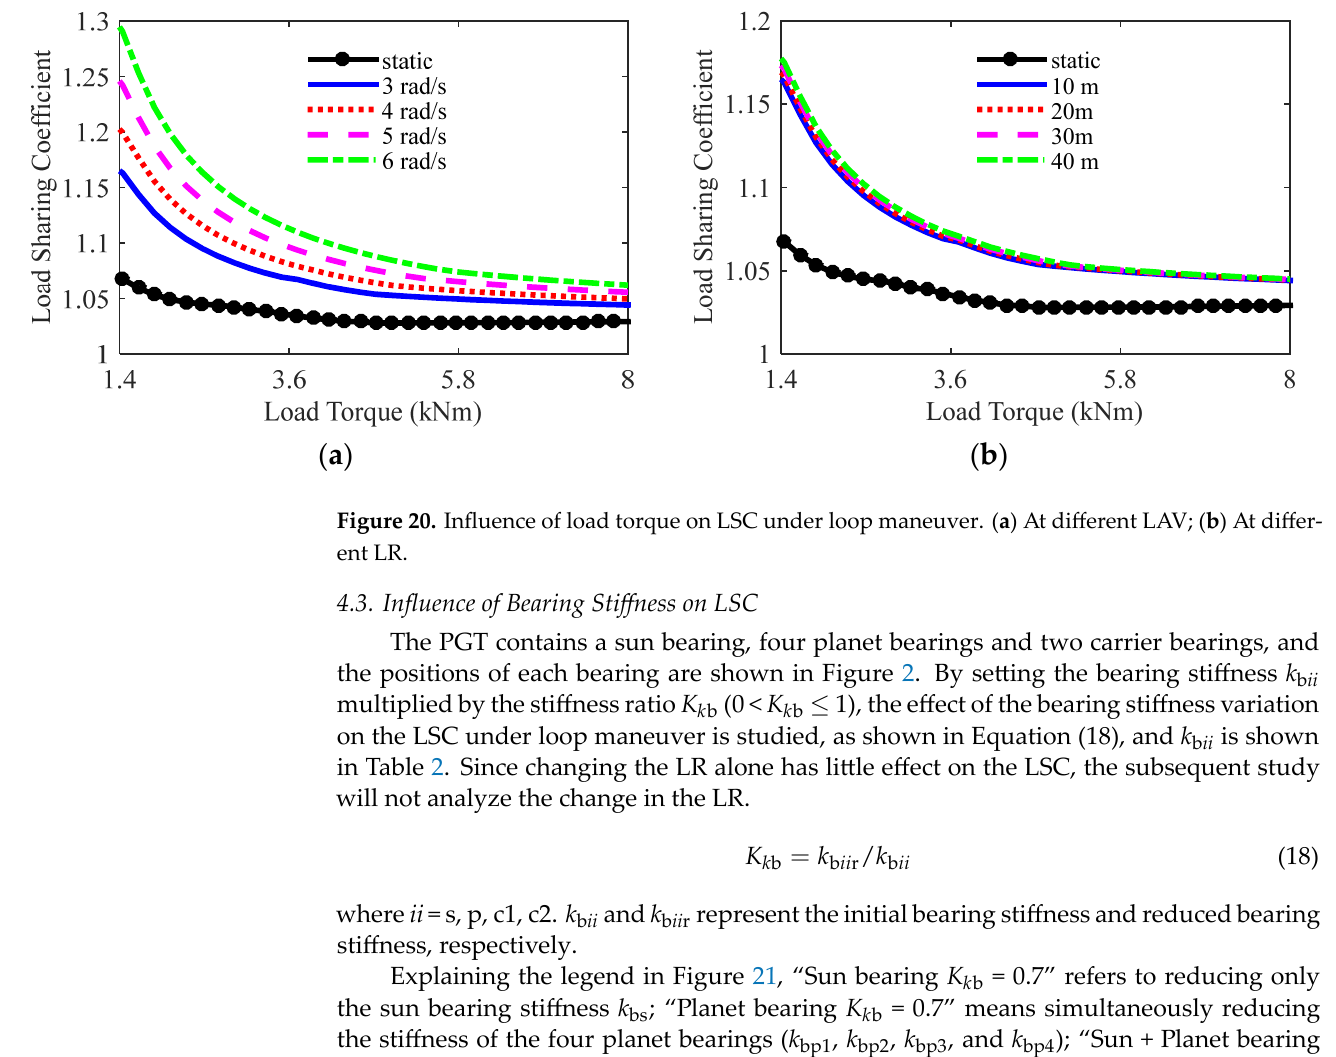
Figure 19. Influence of input speed on LSC under loop maneuver. ( a ) At different LAV; ( b ) At dif- ferent LR.